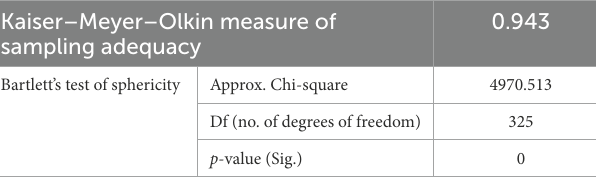
TABLE 5 Kaiser–Meyer–Olkin test (KMO) and Bartlett’s